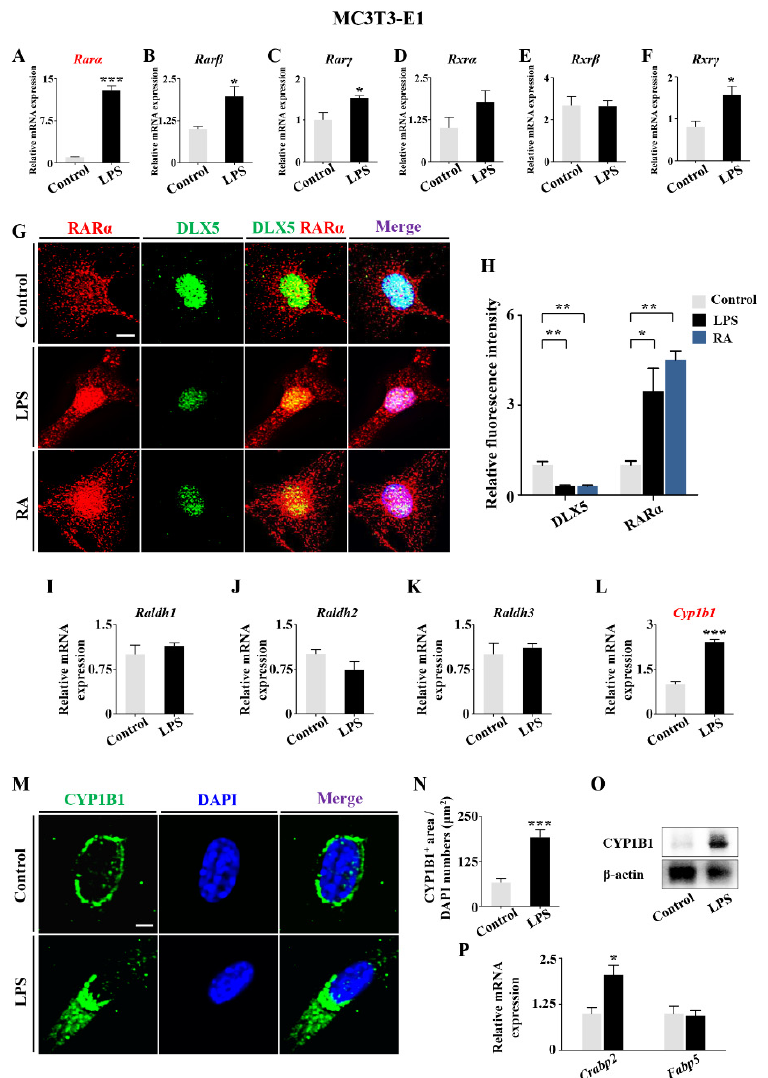
Figure 7. Determining the expressions of RA signaling and DLX5 following LPS treatment. ( A – F ) qPCR data showing the mRNA expression of RAR α ( A ), RAR β ( B ), RAR γ ( C ), RXR α ( D ), RXR β ( E ), and RXR γ ( F ) in MC3T3-E1 cells of control and LPS-treated groups. ( G ) Representative images of RAR α and DLX5 immunofluorescent staining in control, LPS-treated, and RA-treated MC3T3-E1 cells, counterstained with DAPI. Negative controls were shown in Supplementary Materials (Figure S7). ( H ) Immunofluorescent intensity of RAR α and DLX5 expressions was quantitatively measured in control, LPS-treated, and RA-treated MC3T3-E1 cells. ( I – L ) qPCR data showing the expression of Raldh1 ( I ), Raldh2 ( J ), Raldh3 ( K ), and Cyp1b1 ( L ) in MC3T3-E1 cells from control and LPS-treated groups. ( M ) Representative images of CYP1B1 immunofluorescent staining in control and LPS-treated MC3T3-E1 cells, counterstained with DAPI. Negative controls were shown in Supplementary Materials (Figure S7). ( N ) Expression of CYP1B1 in each group was quantified with CYP1B1-positive area / total DAPI-positive cell numbers ( N ) in control and LPS-treated groups. ( O ) Western blot data showing the expression of CYP1B1 in MC3T3-E1 cells of control and LPS-treated groups. ( P ) qPCR data showing the mRNA expressions of Crabp2 and Fabp5 in control and LPS-treated MC3T3-E1 cells. Scale bars = 10 µ m in ( G ); 6 µ m in ( M ). (* p < 0.05, ** p < 0.01, *** p < 0.001).